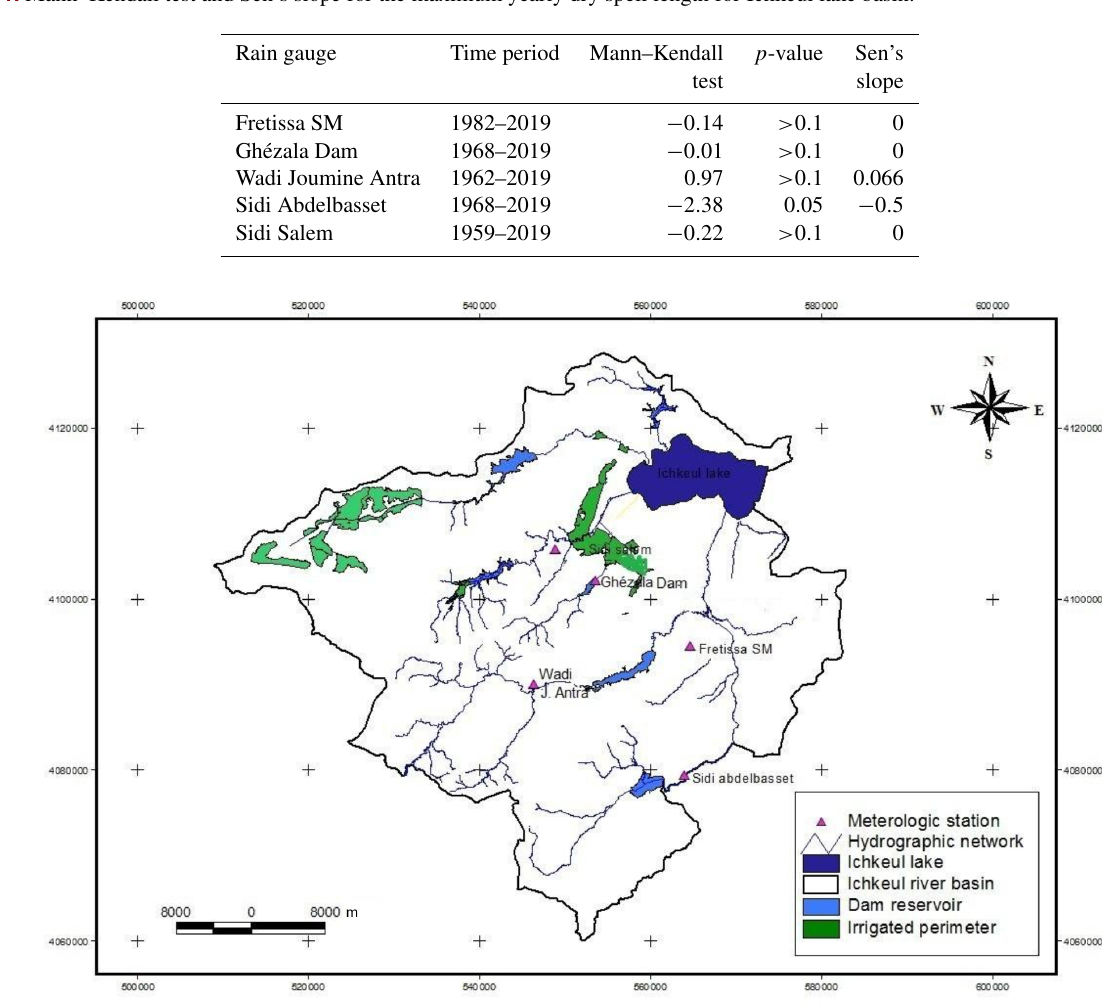
Figure 1. The Ichkeul Lake Basin and the location of gauge stations (the names and the time periods are listed in Table